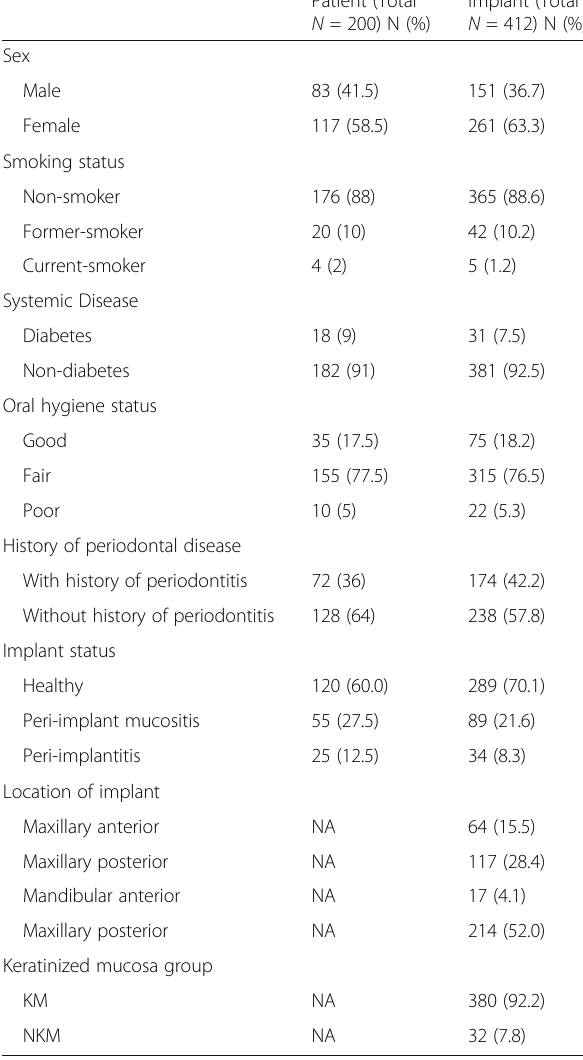
Table 1 Demographic data and clinical